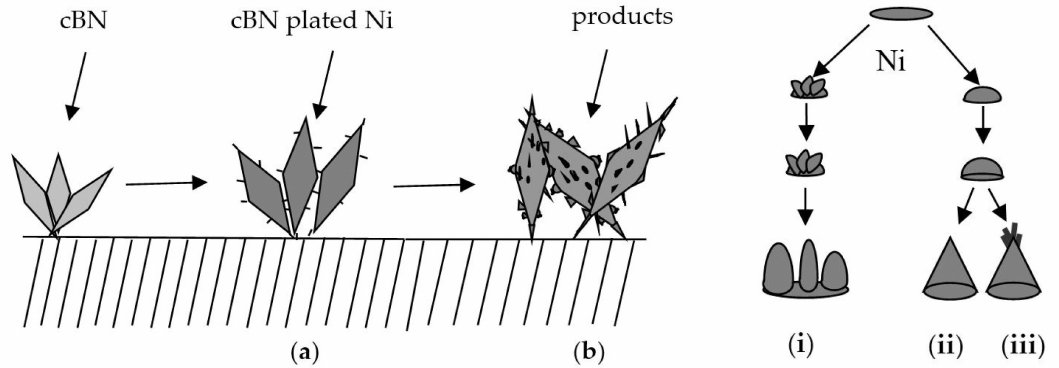
Figure 4. Schematic illustration of the forming processes of: ( a ) Ni spines plated cBN and ( b ) three Ni spines: ( i ) multiple spines, ( ii ) icicle spines and ( iii ) pronged